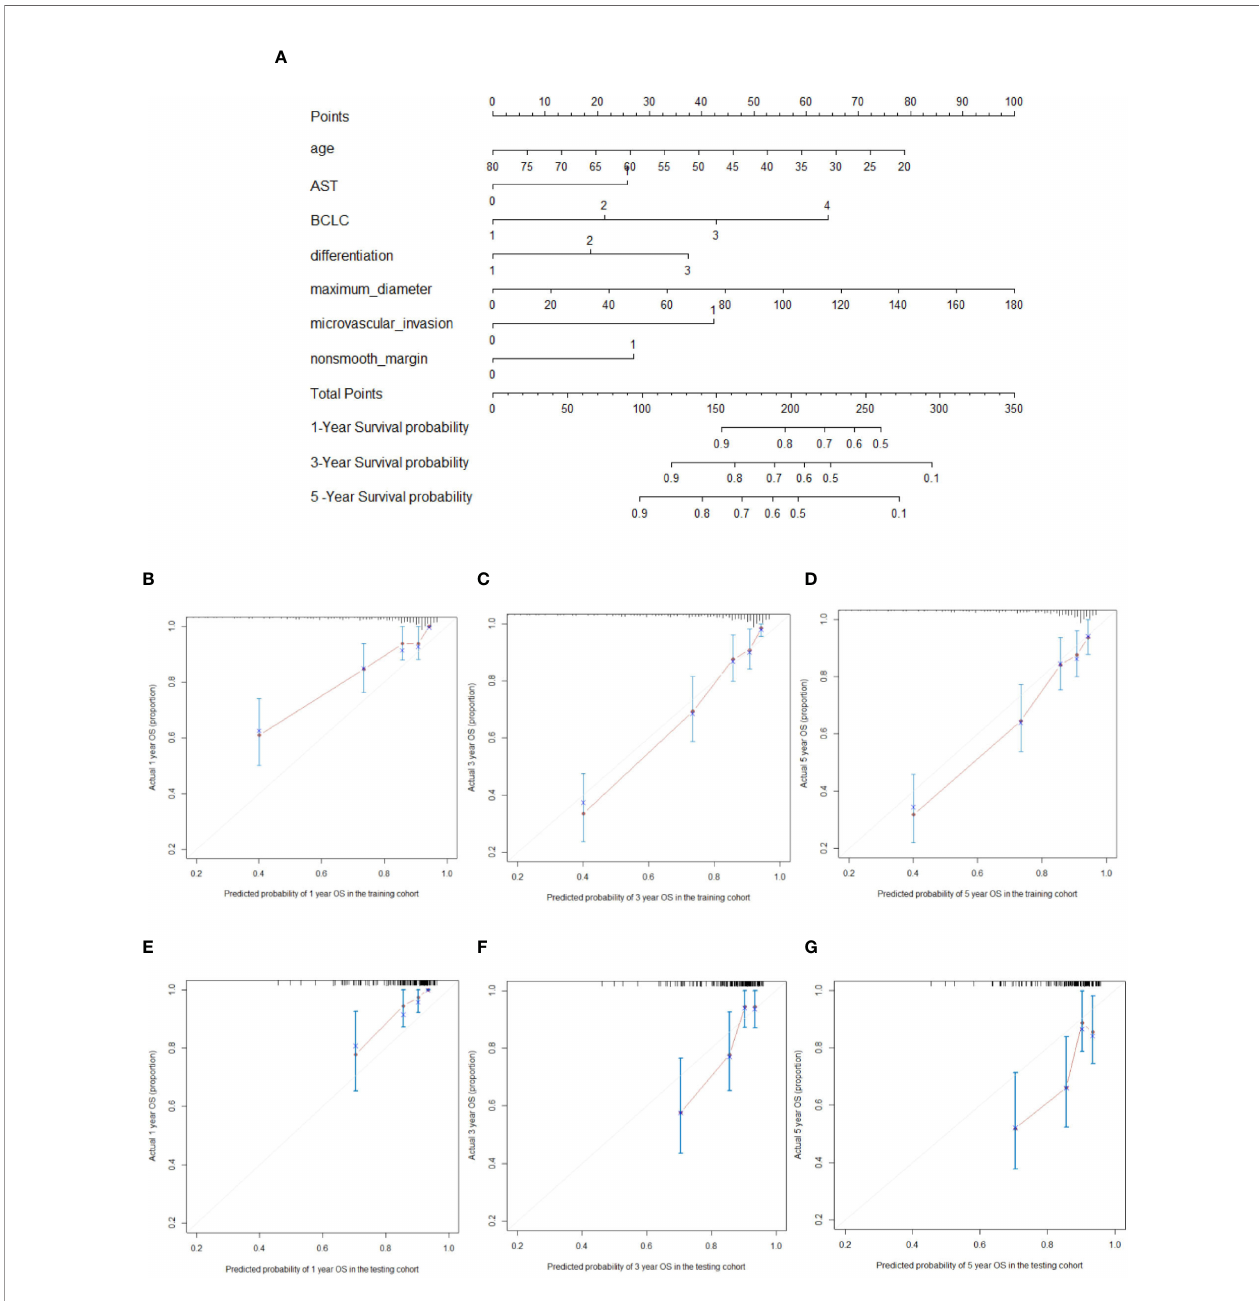
FIGURE 1 | Nomogram for predicting overall survival (OS) ( A ; “ 1, 2, 3, 4 ” on the BCLC scale represent BCLC 0 A B C respectively). For every predictor, a straight vertical line upward was projected to identify the points. The total points bar was used to plot the accumulated points, and a straight vertical line yielded the 1-, 3-, and 5-year predicted post-hepatectomy survival risk. The calibration curves for predicting the 1-, 3-, and 5-year OS in the training cohort (B – D) and testing cohort (E – G) in hepatocellular carcinoma patients who underwent